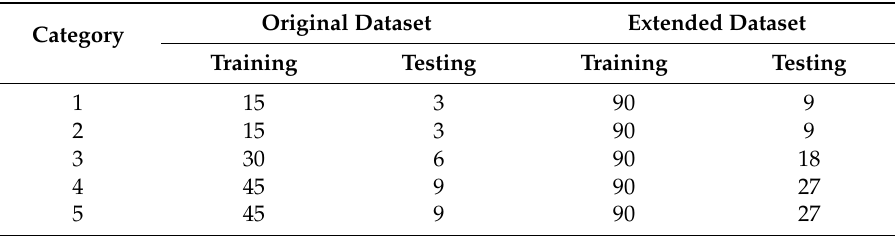
Table 8. Original dataset and extended dataset.